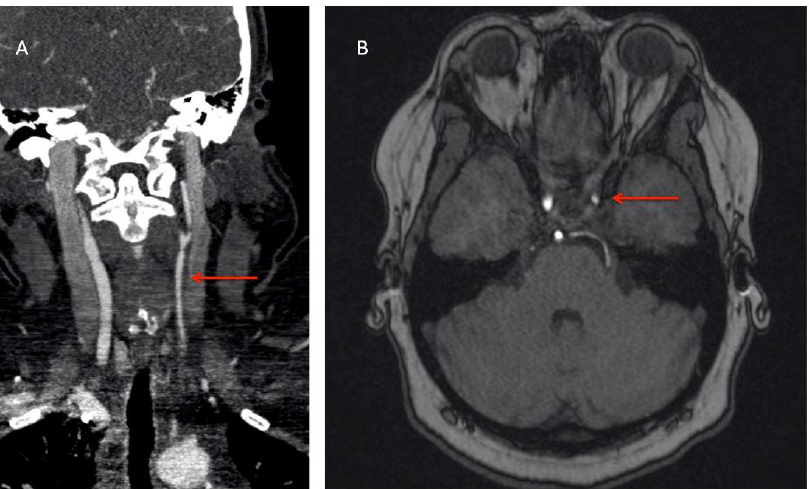
Figure 2. ( A ) CT-A demonstrating extensive, diffuse narrowing of the left common carotid artery and extracranial internal carotid artery; ( B ) MR brain with and without contrast showing left internal carotid artery terminus narrowing.